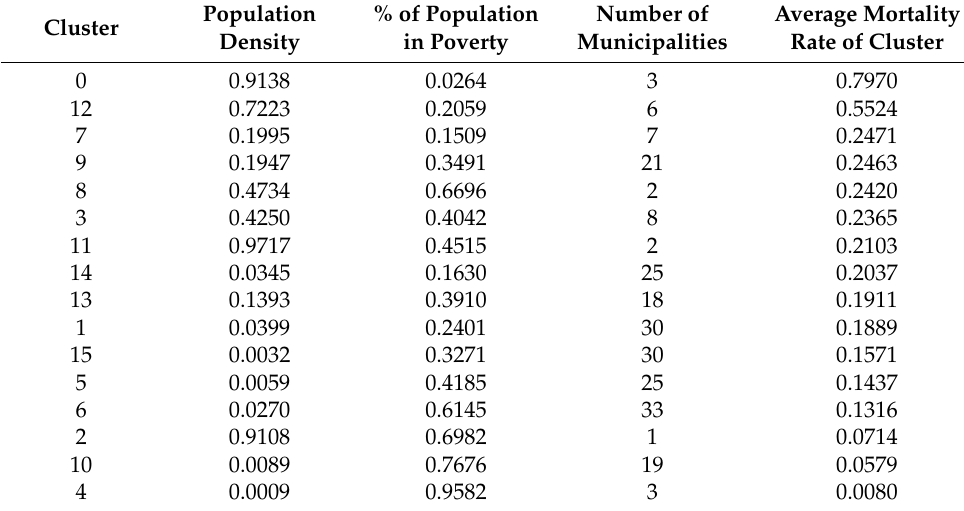
Figure 3 allows visualizing the distribution of the cluster centroids and the municipalities close to the centroids. Some of the centroids are overlapped in the areas of high dots density.